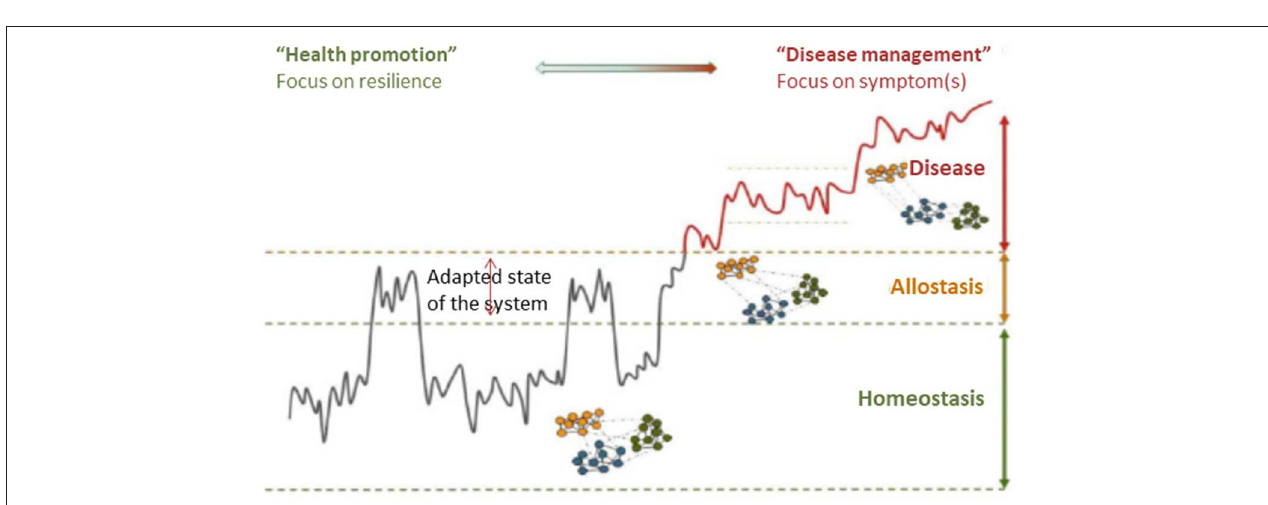
FIGURE 4 | A framework for understanding the progression of healthy homeostasis to disease. For chronic diseases, the pathological development toward a disease state typically takes years. While the medical world has made tremendous progress toward the measurement of disease, the ability to measure the progress toward the disease is lacking. Resilience as measure of health status provides a promising solution to this problem. In contrast to the classical symptom/biomarker approach, challenge tests are used to measure resilience as an early biomarker of disease or (nutritional) effect. Reprinted with permission from van der Greef et al.